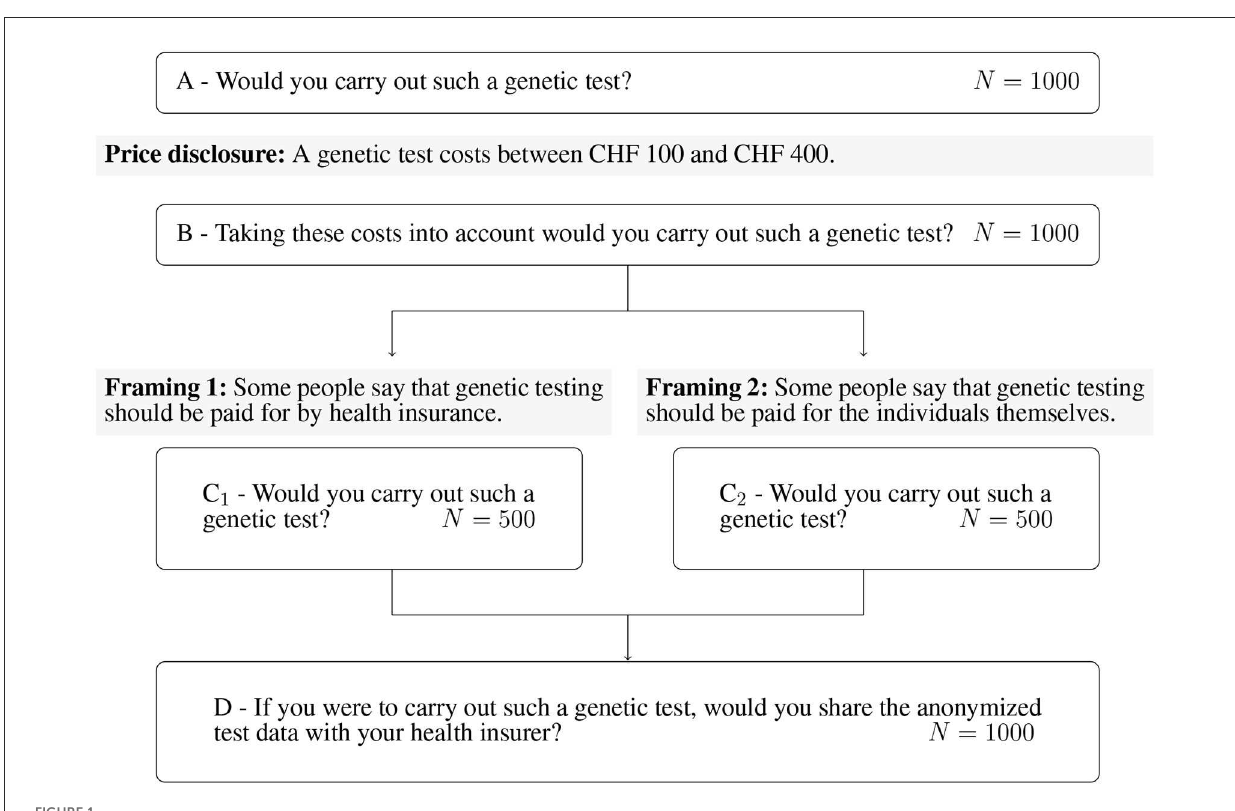
FIGURE1 Survey setup, core questions, and